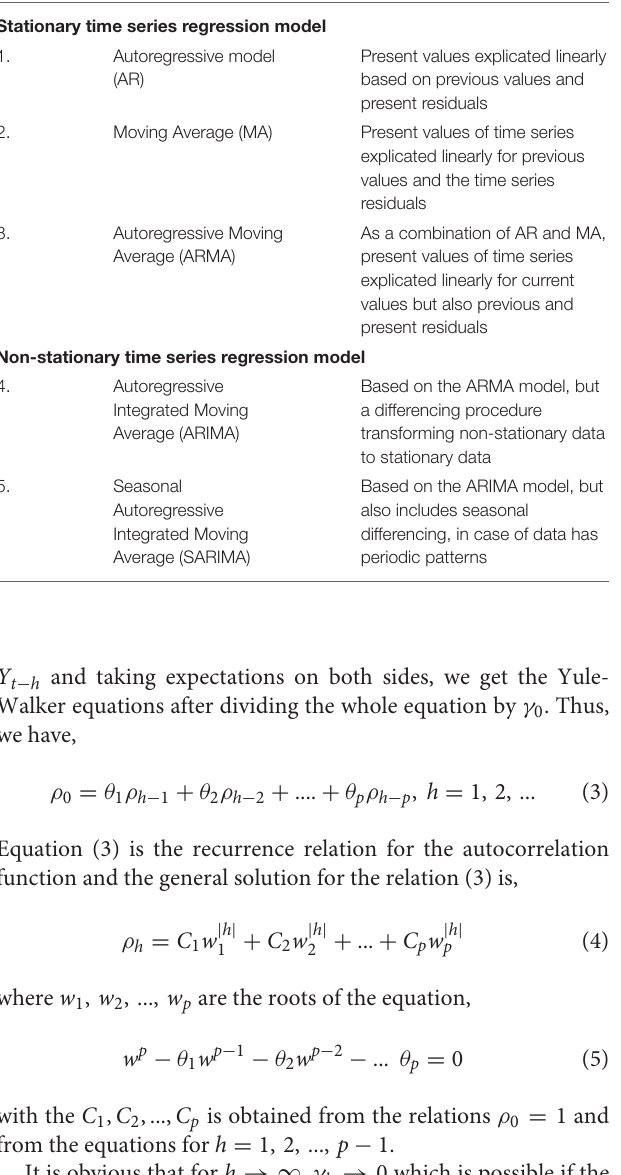
TABLE 2 | Stationary and non-stationary time series regression models used in epidemiology. S.